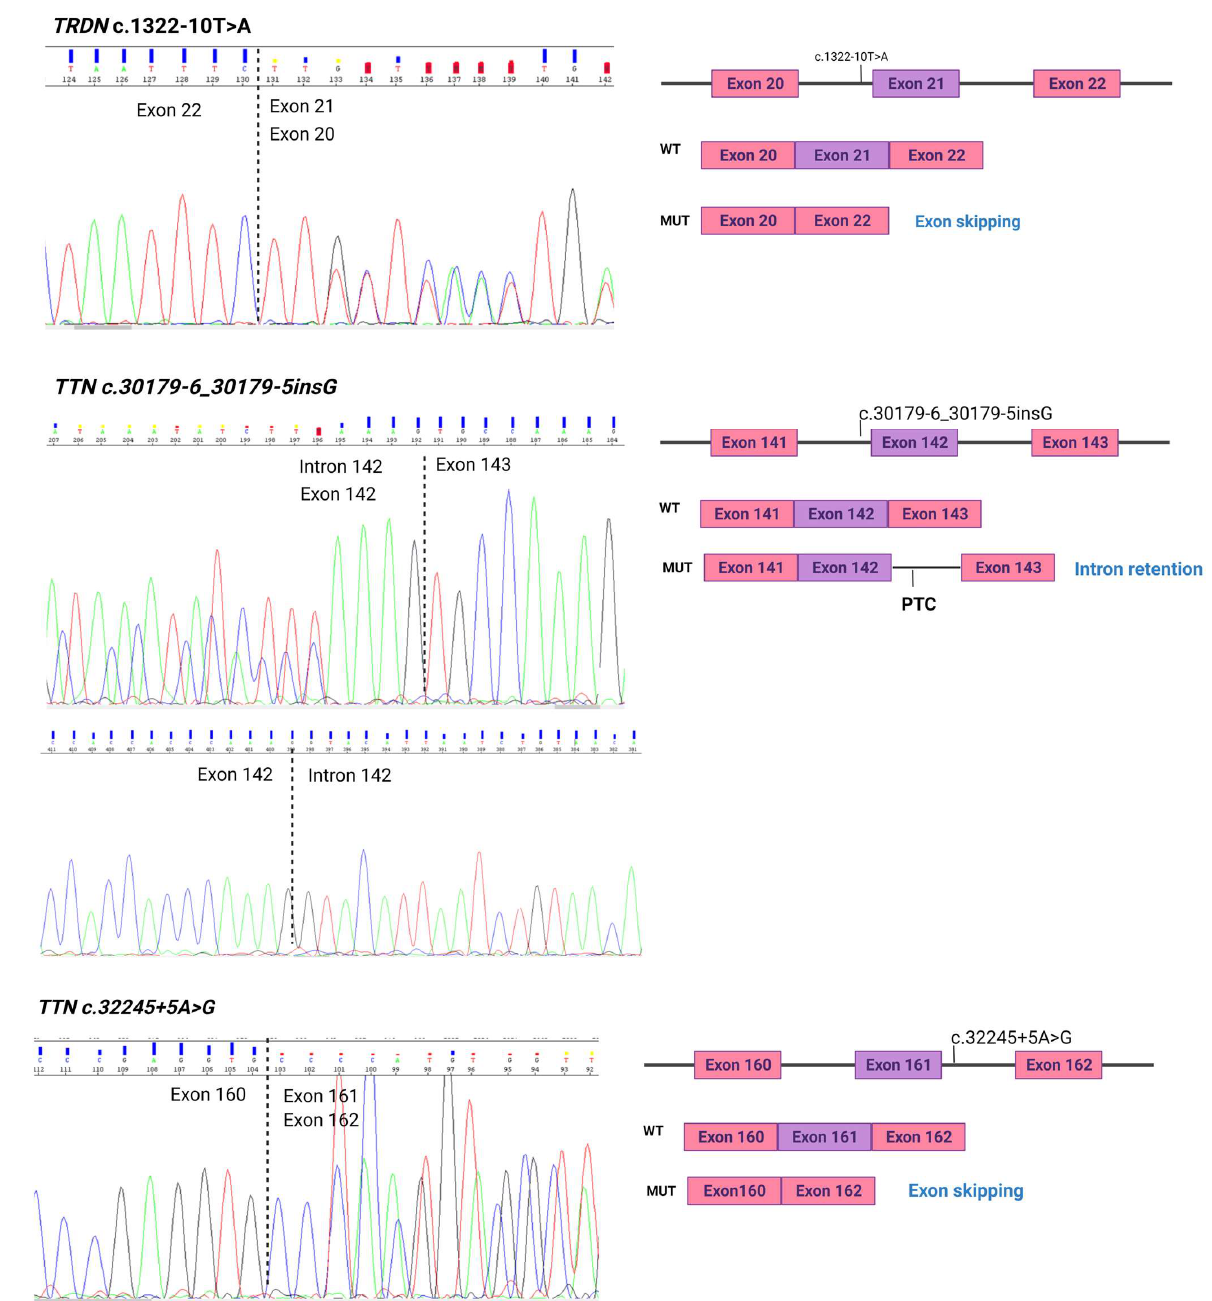
Figure 3. Unpredicted aberrant splicing products.